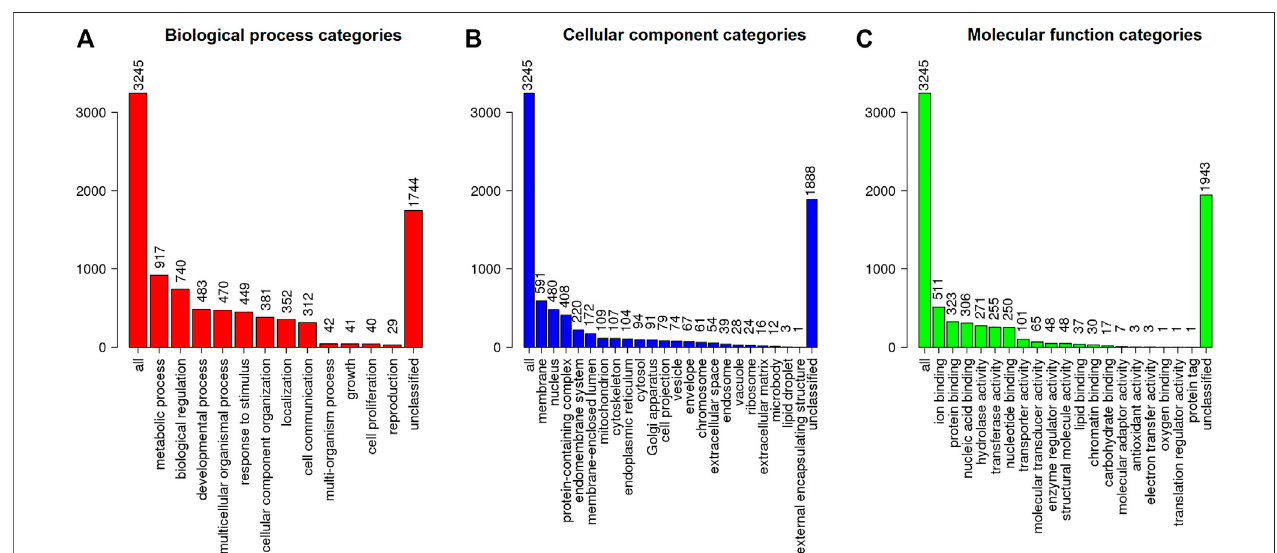
FIGURE 2 | Functional classi fi cation (according to Gene Ontology) regarding the (A) biological process, (B) cellular component, and (C) molecular function for predicted genes from S. brasiliensis .